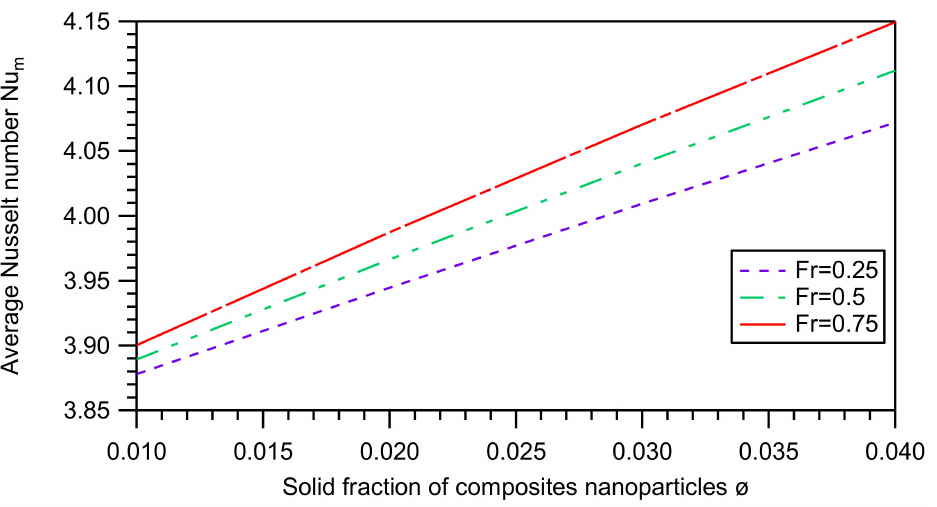
Figure 20. The average Nusselt number Nu m for di ff erent fractional values of Ag in the volumetric fraction of nanoparticles (Fr = 0.25, 0.5 and 0.75) with Ra = 10 5 , Ha = 15, Da = 10 − 2 , AR = 0.3, and q ∗ =